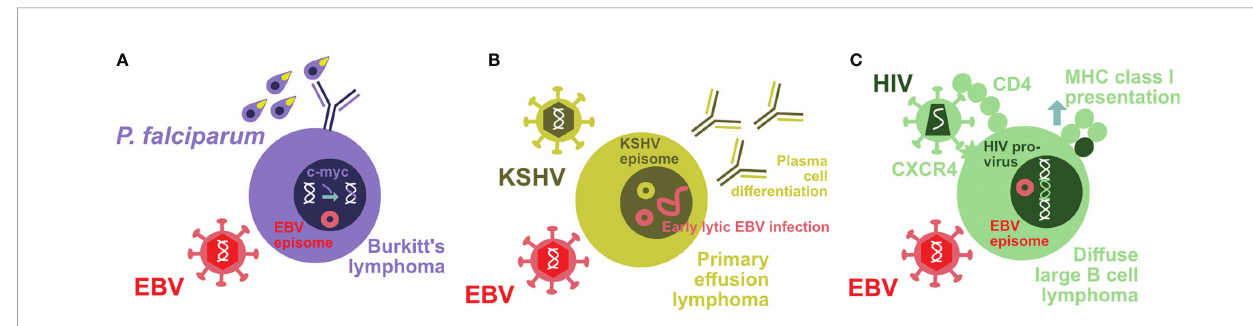
FIGURE 1 | Coinfections modify EBV-associated lymphomagenesis. (A) Holoendemic Plasmodium falciparum ( P. falciparum ) exposure is associated with endemic Burkitt ’ s lymphoma. The characteristic c-myc translocation in these uniformly EBV-infected tumor cells might be driven by parasite-induced B cell differentiation. (B) Primary effusion lymphoma is to 100% KSHV and to 90% EBV infected. KSHV infection drives the characteristic plasmablastic differentiation of these tumor cells that in turn leads to increased early lytic EBV reactivation. (C) HIV is able to infect EBV-transformed B cells by virtue of their CD4 upregulation and maintained CXCR4 expression. The resulting double-infected B cells with integrated HIV provirus upregulate MHC class I antigen presentation and are therefore ef fi ciently eliminated by CD8 + T